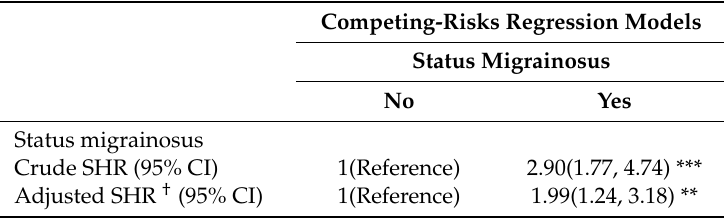
Table 4. Status migranosus cohort compared to comparison cohort subhazard ratio (SHR) of suicide attempts estimated using the competing-risks regression models.